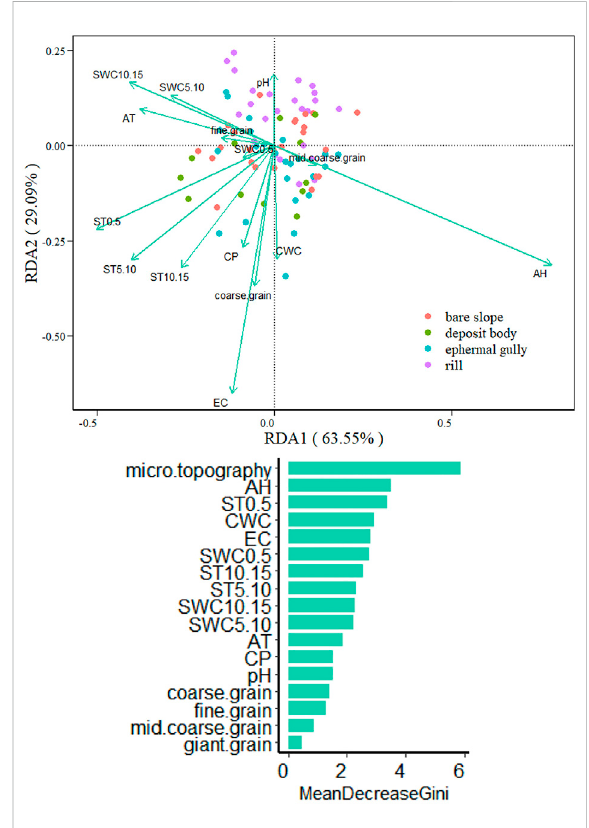
FIGURE 5 Redundancy analysis (RDA) of samples and environmental factors (left-hand), and random forest (RF) analysis of environmental factors and micro-topography types (right-hand) as predictors for the classi fi cation of seedling emergence. A meandecreaseofGinivalueswasusedtoestimatetheimportance ofthesepredictors:ahighermeandeclineinGinivaluessuggested more important